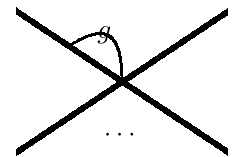
Figure 8 . Another diagram contributing to (cid:0) ( n ) . We can also have a diagram where both ends of the internal graviton are attached to the n -scalar vertex, but this vanishes in dimensional regular- ization and so we have not displayed